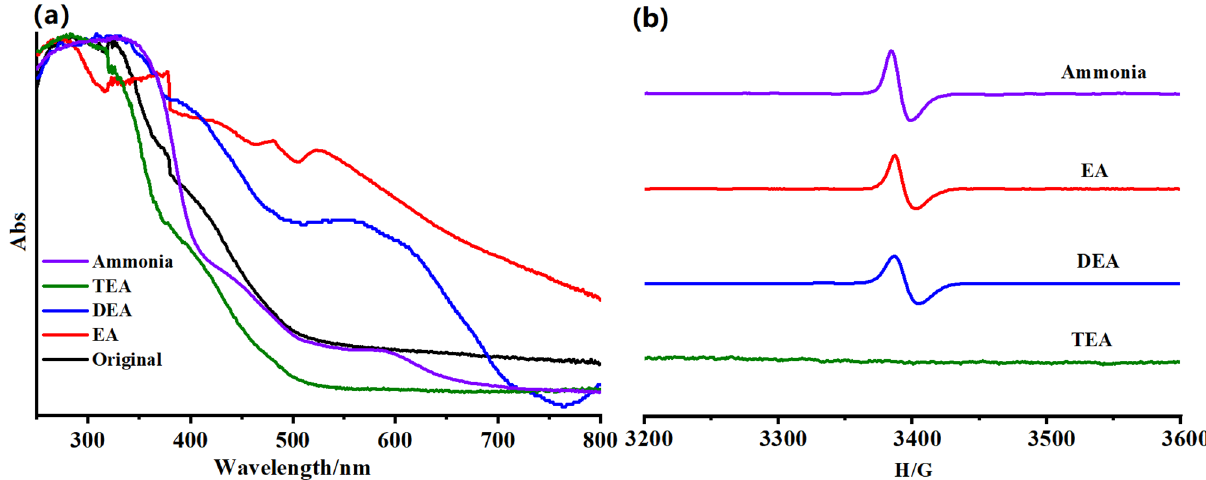
Figure 5. ( a ) Normalized UV − vis absorption spectra and ( b ) EPR spectra of compound 1 before and after exposure to different volatile amine/ammonia vapors, (EA = ethylamine, DEA = diethylamine and TEA = triethylamine).